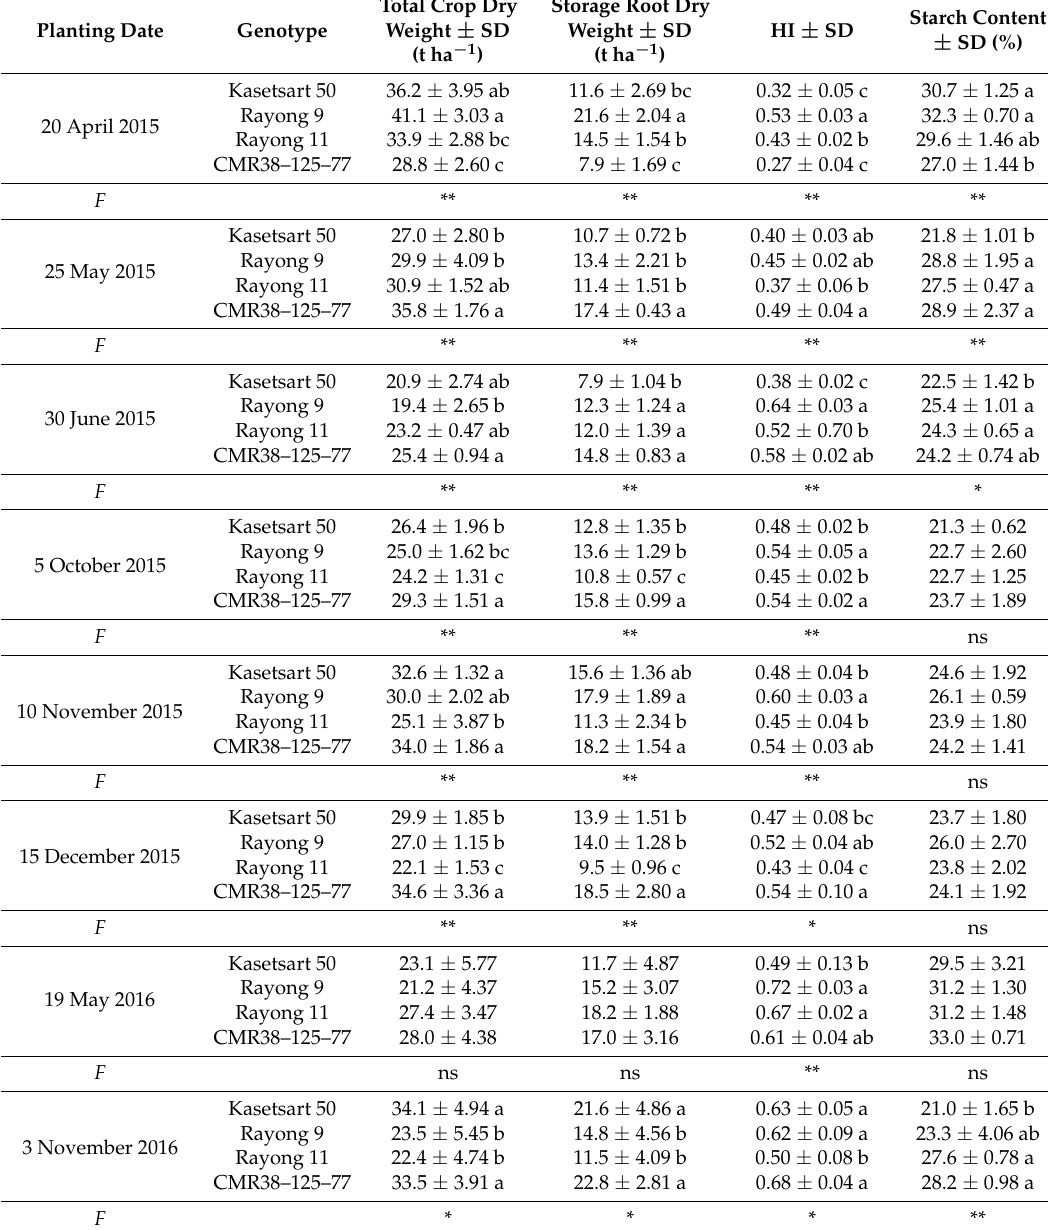
Table 5. Total crop dry weight, storage root dry weight, harvest index (HI), and starch content at 300 days after planting (DAP) of four cassava genotypes grown at different planting